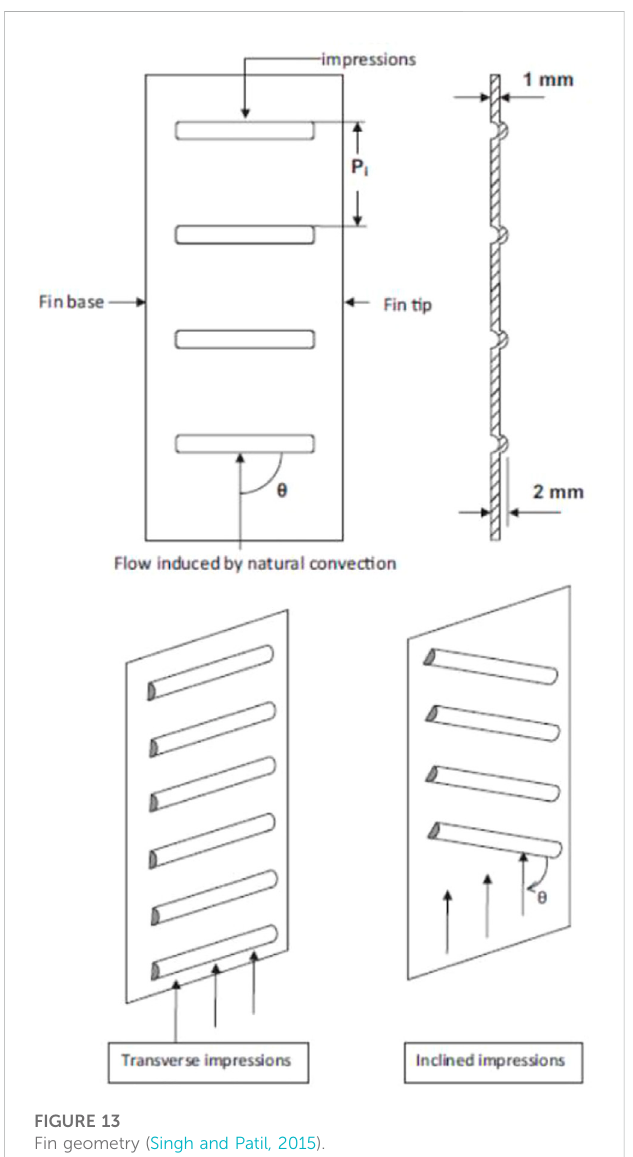
FIGURE 13 Fin geometry (Singh and Patil, 2015).